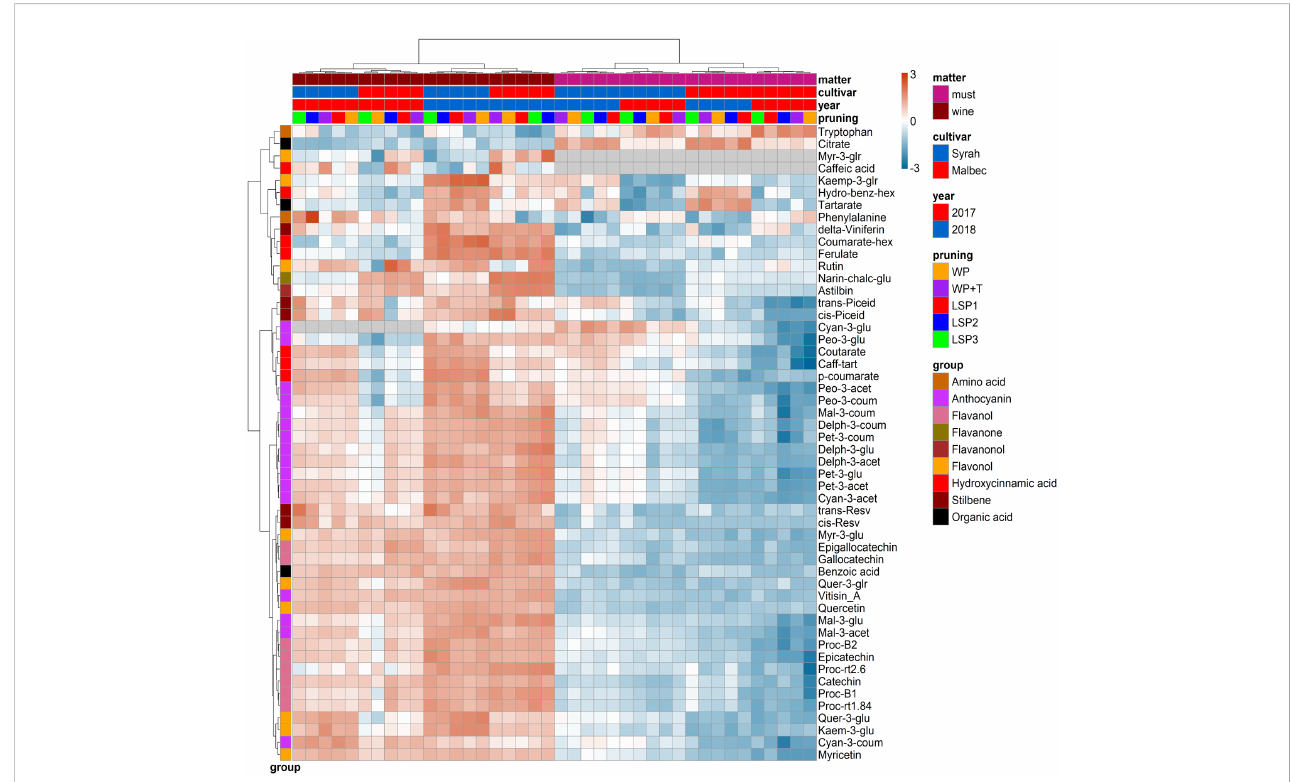
FIGURE 1 Hierarchical clustering heatmap obtained from cluster analysis. Cluster sharply divided the samples based on the kind of sample (wine vs must) then cultivar , year and pruning treatments. Samples from the most extreme late shoot pruning treatments ( “ LSP3 ” and “ LSP2 ” ) and samples from the no-late pruning treatments ( “ WP+T ” and “ WP ” ) seemed to form two different groups. The late shoot pruning treatment “ LSP1 ” alternatively clustered with one of the two